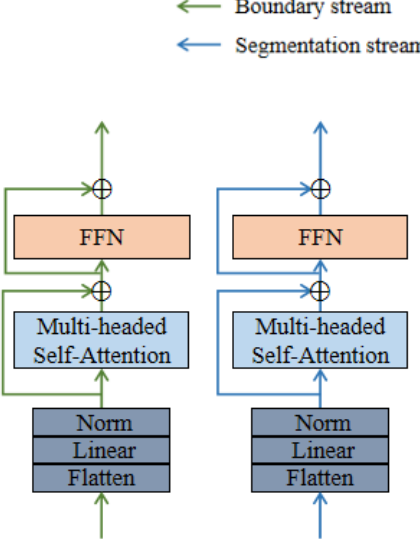
Figure 7. Transformer conversion head.